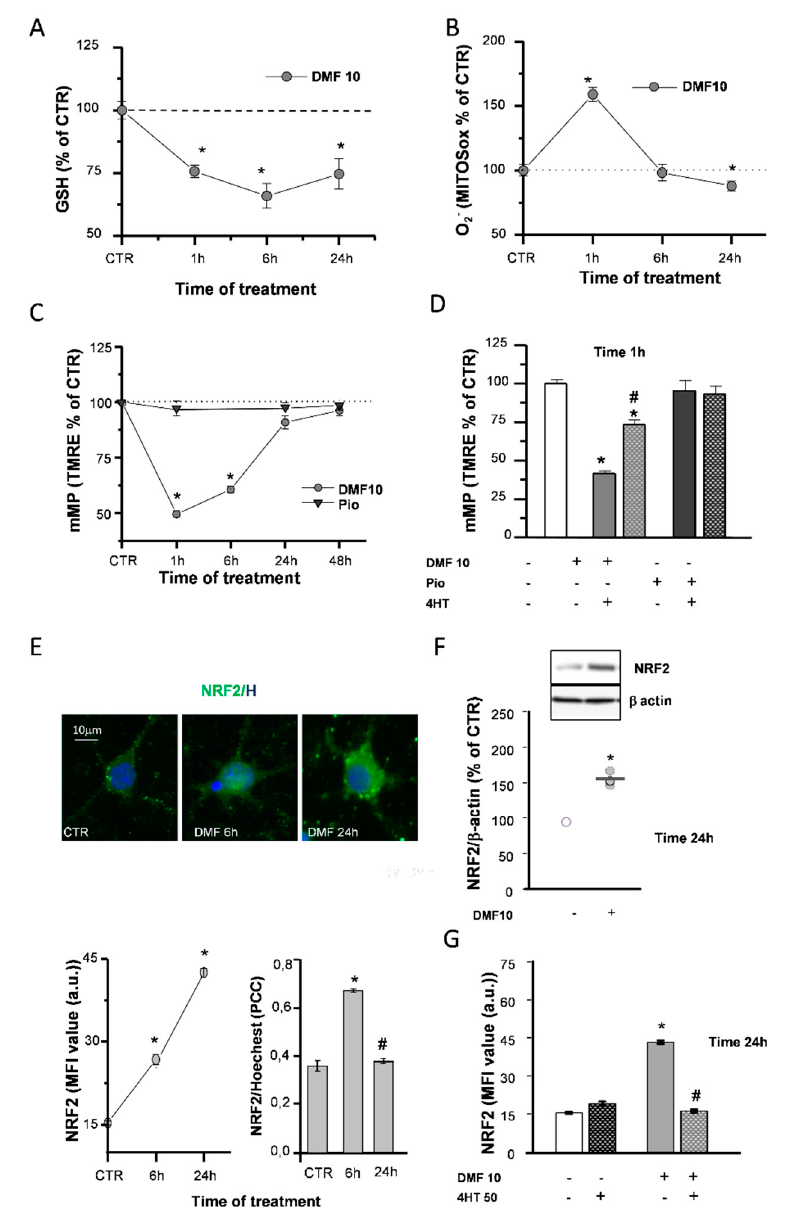
Figure 2. DMF causes early e ff ects on the mitochondria and NRF2 induction. Glutathione (GSH) levels were measured by a luminescence assay kit to evaluate the effects of 10-µM DMF at different time points (1, 6, and 24 h) ( A ). Untreated (CTR) is taken as 100%. Experimental points are mean ± SEM of n = 4 experiments (* p < 0.05 vs. CTR). Fluorescence intensities of single cells loaded with the mitochondrial superoxide sensitive probe (MitoSOX) were measured at different time points (1, 6, and 24 h) during 10-µM DMF treatments ( B ). Intensity values were normalized to the untreated (CTR) value and shown as mean ± SEM from n = 317-507 cells (* p < 0.05 vs. CTR). Tetramethylrhodamine-ethyl ester (TMRE) fluorescence intensities of single mitochondria were measured at different time points (1, 6, 24, and 48 h) during treatments with 1-µM pio or with DMF 10µM ( C ). Data are expressed as mean ± SEM from n = 120–1627 mitochondria (* p < 0.05 vs. CTR). Oligodendrocyte progenitor (OP) cultures were treated for 1 h with 10-µM DMF or 1-µM pio alone or with 50-µM 4-hydroxy-TEMPO (4HT) pretreatment. TMRE fluorescence intensity was measured. CTR is taken as 100%. Data are expressed as mean ± SEM from n = 45–182 mitochondria (* p < 0.05 vs. CTR and # p < 0.05 vs. DMF) ( D ). OP cultures treated with 10-µM DMF for different time points (6 and 24 h) were immunostained for NRF2 and Hoechst ( E ). The panel above shows micrographs of exemplifying cells in different conditions. The panel below shows the mean fluorescence intensities (MFI) of NRF2 and the colocalization of NRF2 and Hoechst evaluated by Pearson’s correlation coefficients (PCC). PCC = 1